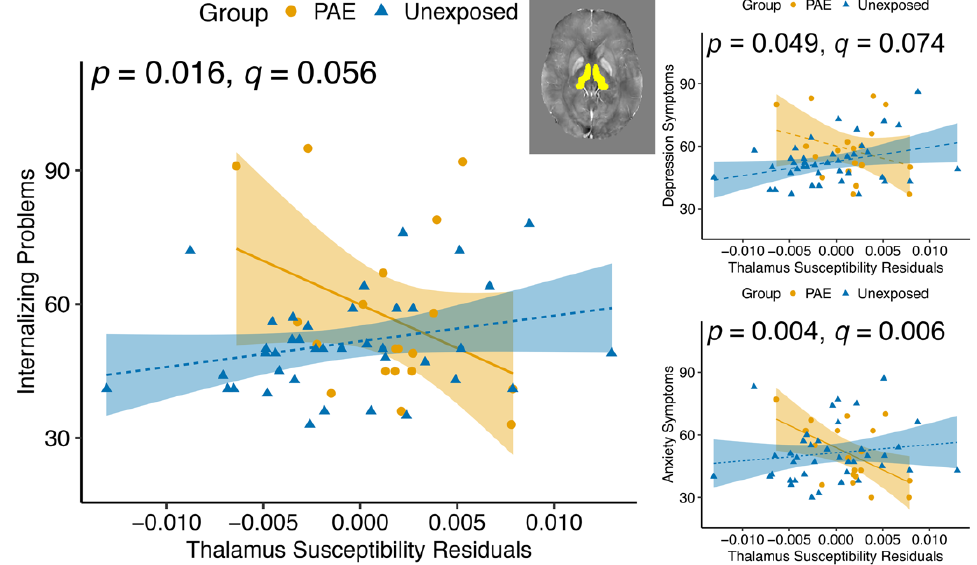
Figure 4. Group – susceptibility interactions in the thalamus were significant for Internalizing Problems, Depression, and Anxiety symptoms. Within the PAE group, susceptibility was more negatively associated with Internalizing Problems, Anxiety, and Depression symptoms than in unexposed controls. Susceptibility values are corrected for age and gender. p values indicate the group – susceptibility association. Dashed lines indicate non-significant associations within a group.